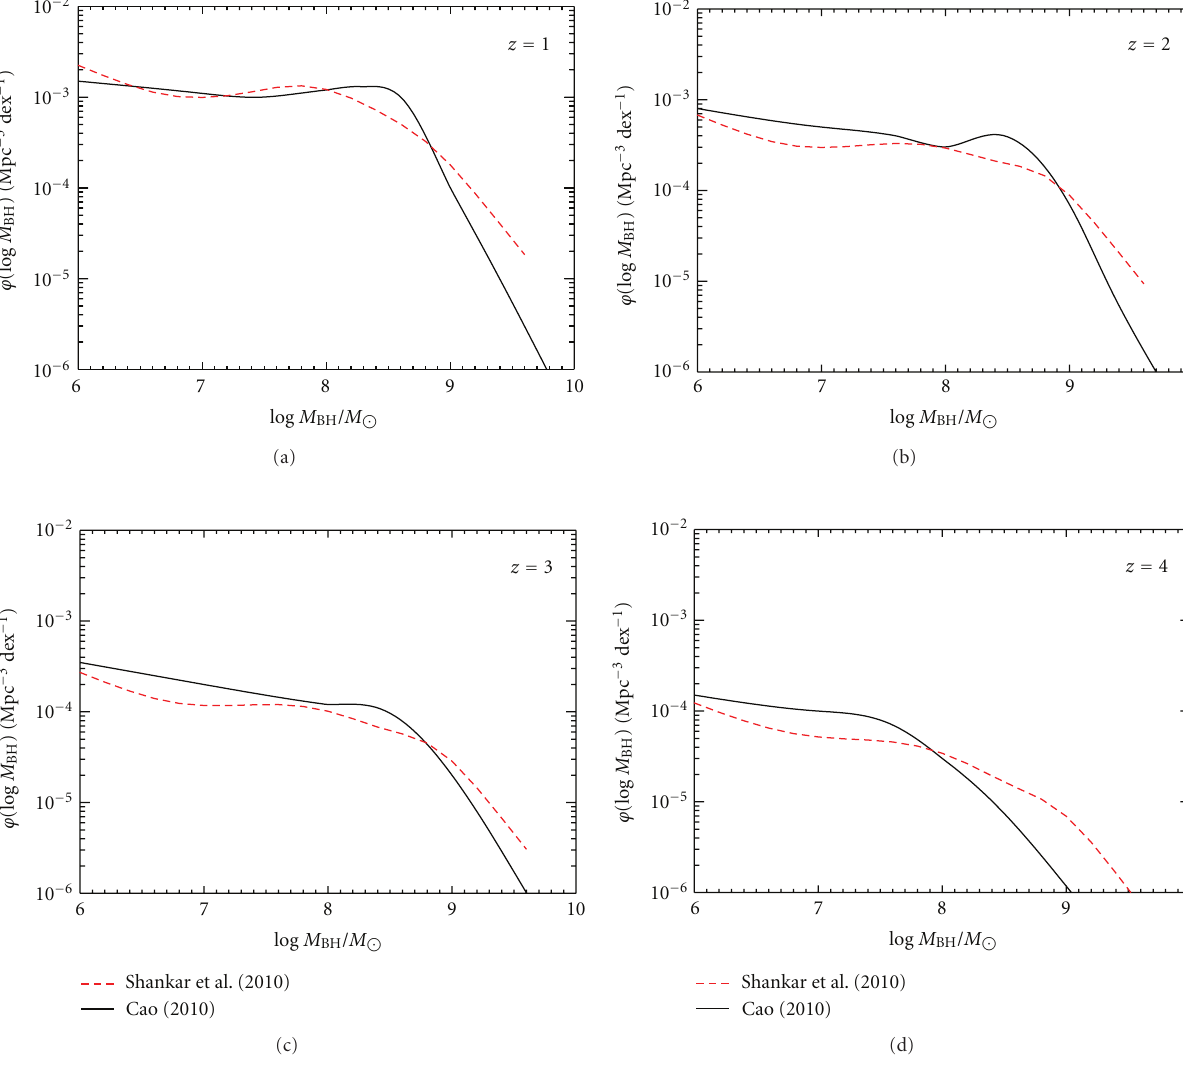
Figure 3: Comparison of two recently estimated BHMFs, calculated by Shankar et al. [64] (red dashed line) with that calculated by Cao [92] (solid black line). Both BHMFs were estimated by assuming a quasar lightcurve, where Shankar et al. [64] used a step function model while Cao [92] assumed a power-law decay. Despite the two di ff erent models, the BHMFs are similar at a variety of redshifts, except at possibly the high-mass